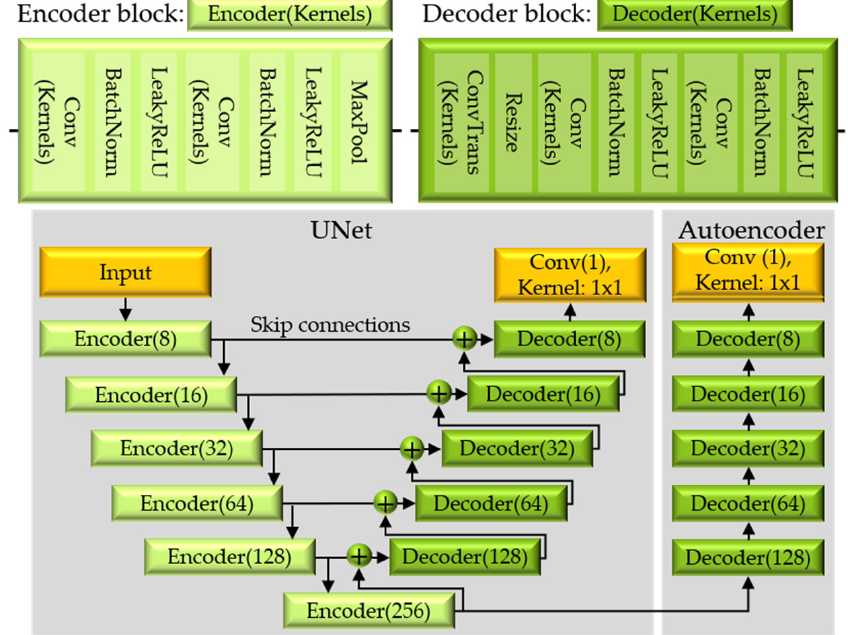
Figure 4. Structure of the autoencoder and UNet.